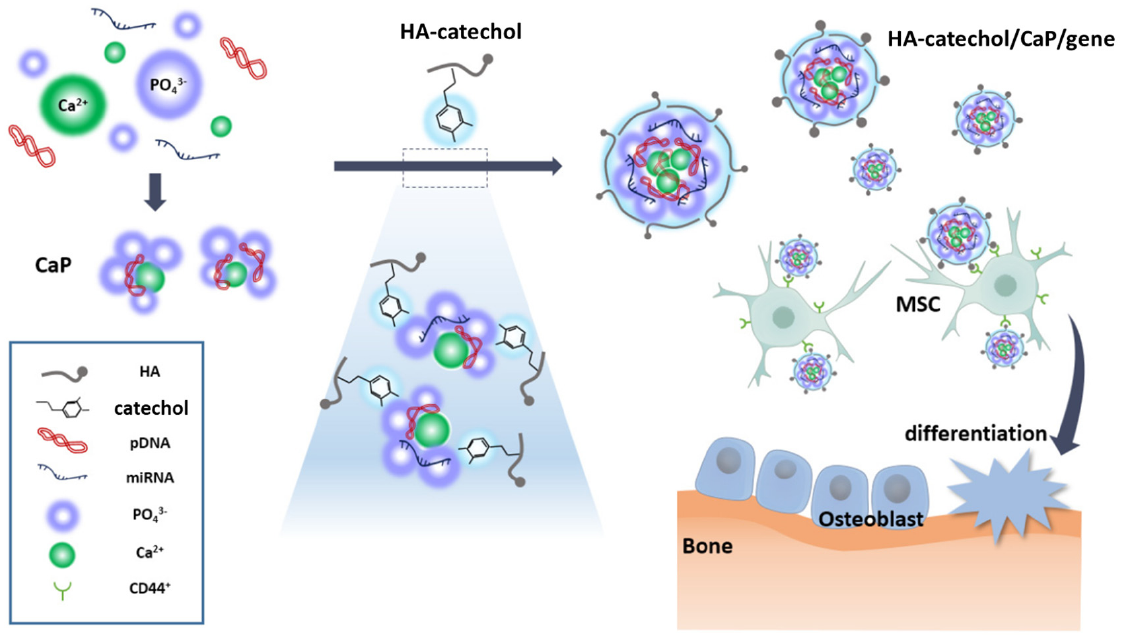
Figure 6. Schematic representation of an HA–catechol/CaP-based gene delivery system. Reproduced from [41] with permission from MDPI, copyright